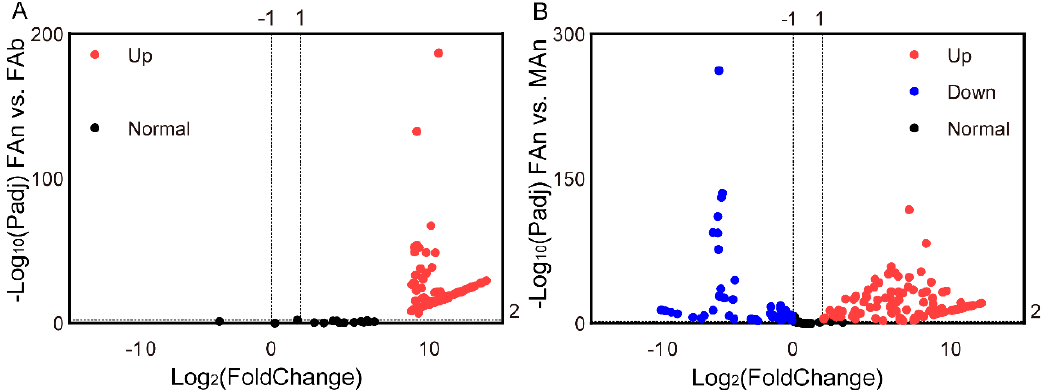
Figure 4. The differentially expressed genes ( A ) between the abdomen and antennae of the female and ( B ) between the female and male antennae. The adjusted p value < 0.01 and |log 2 (FoldChange)| > 1 were set as the significantly differential expression threshold.